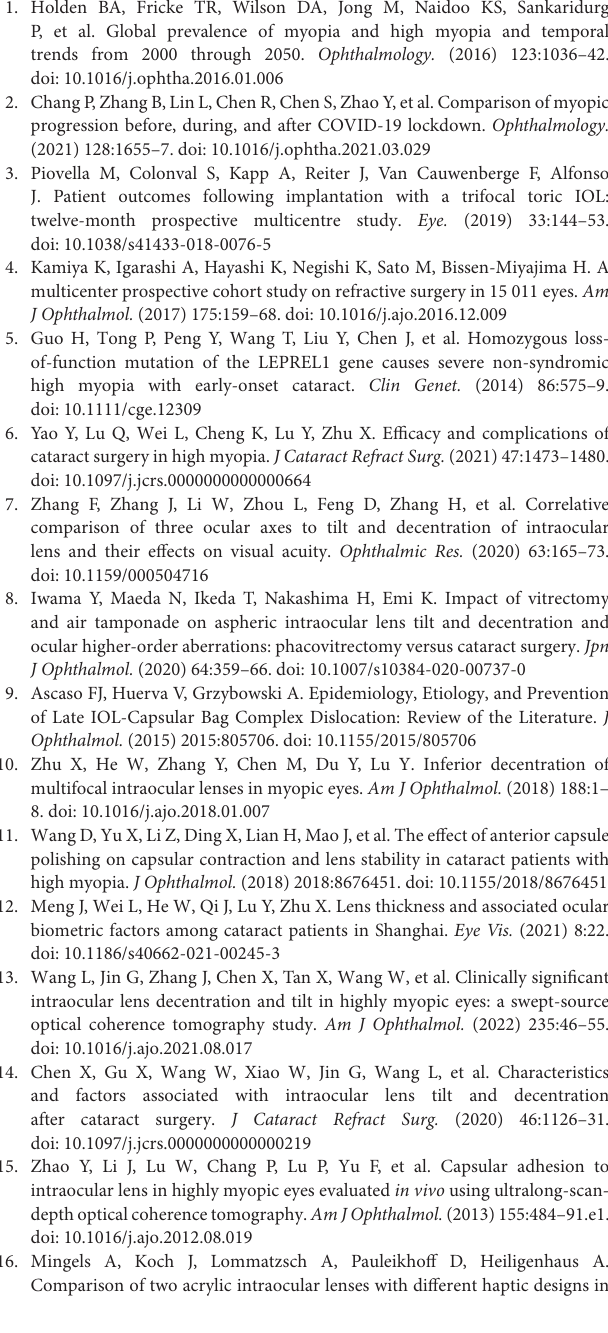
Significantly greater IOL weights were found in Group B compared to Group A ( P < 0.001). Post-operative UDVA and CDVA did not show significant differences between the two groups at 3 years after surgery (both P >